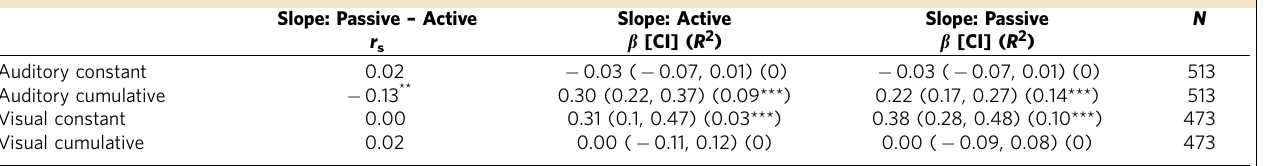
Statistical tests to compare the template fitting resultsfrom the activeand passivesessions. Thefitting parametersfrom the Activetask were those obtained afterapplying Passiveweights to the Active task data (Supplementary Fig. 1). To test whether the slope of the relationship between each delay parameter and age differed across the two tasks, we calculated the difference between Passive and Activetasksforeachparticipant,andusedaSpearman’scorrelationtotestwhetherthesedifferencescoreswererelatedtoage.Theage-effectwasonlysignificantlydifferentacrosstasksfortheauditory cumulative delay parameter (with a higher age-effect in the Active task). Data were removed from both Passive and Active tasks if an outlier existed in any column for a given modality, so that Passive and Active data sets contained equal numbers of participants. * P o 0.05, ** P o 0.01, *** P o